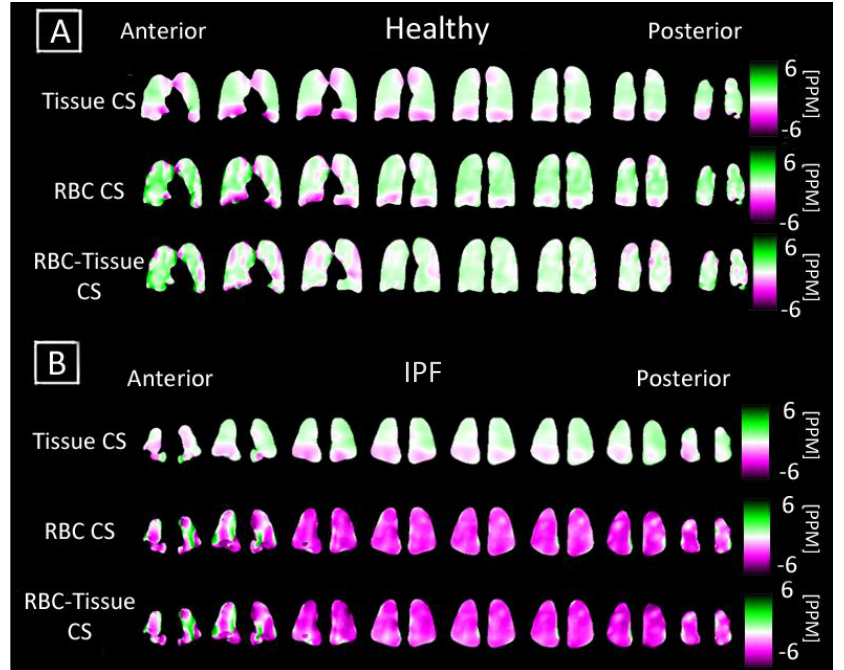
Figure 5. Coronal maps of 3D-SBCSI Tissue Chemical Shift (CS), RBC Chemical Shift in a ( A ) healthy subject H4 and ( B ) IPF subject I9. The respective chemical shift maps were normalized to show how each voxel deviated from their expected tissue chemical shift (197 ppm) and RBC chemical shift (216 ppm). Regions with higher values in the RBC T2* map corresponded with regions of higher